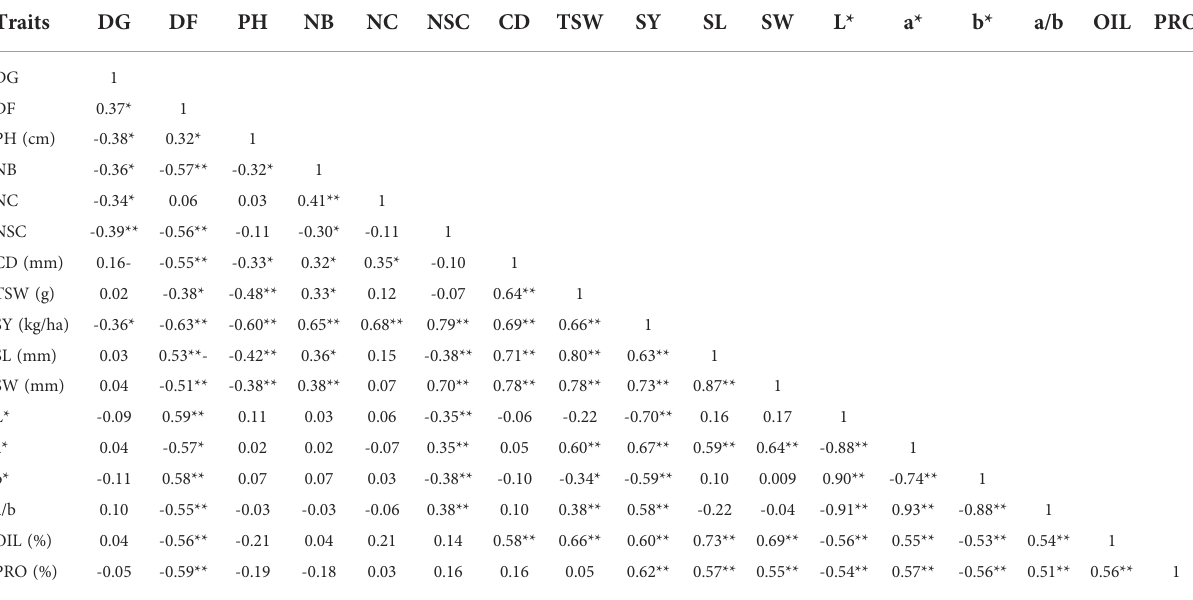
TABLE 4 Genotypic correlation coef fi cient used to assess correlation among the seed coat color, seed yield parameters and quality traits of 144 fl ax genotypes.